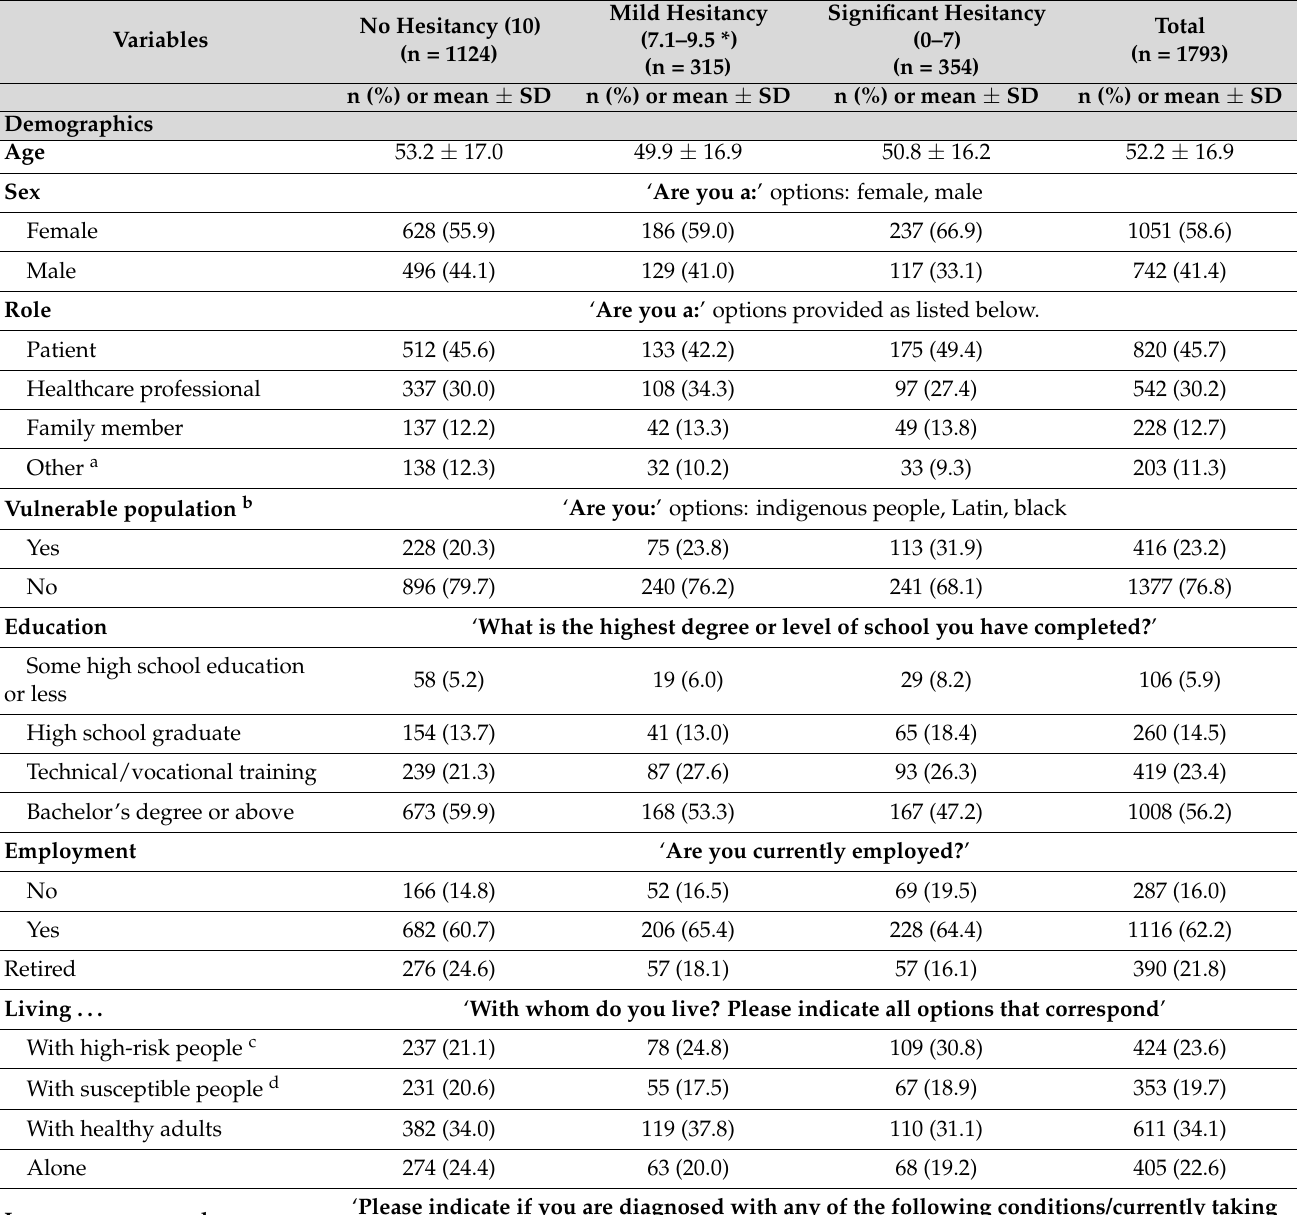
Table 1. Participants’ characteristics according to their likelihood to receive a COVID-19